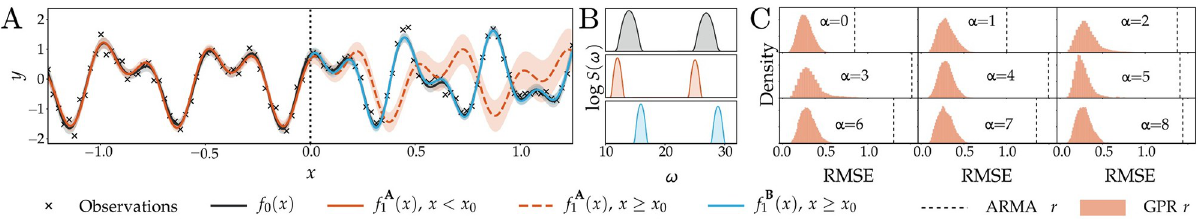
and M . The data were generated with a post-intervention frequency 0 1